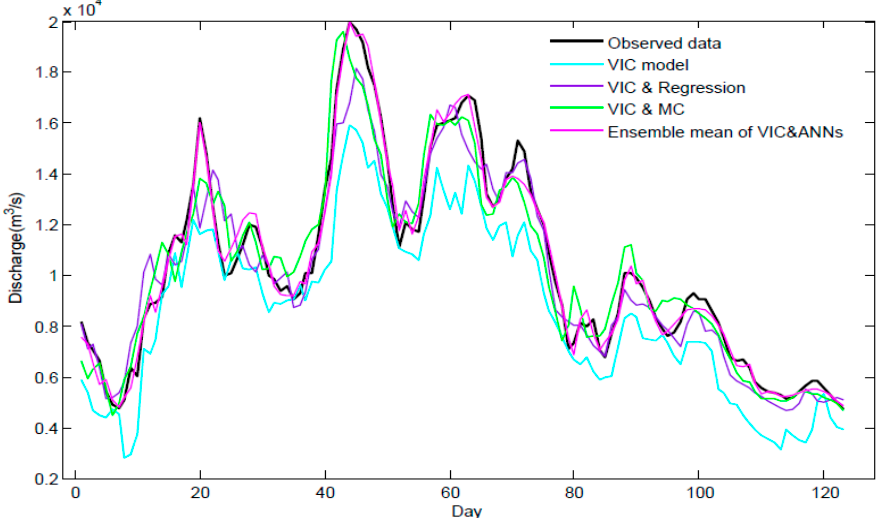
Figure 9. Comparison of the observed and estimated daily runoff hydrographs from the VIC model, VIC and ANN ensemble mean model, VIC and linear regression model and VIC and MC model during the calibration period (July to October, 2005).